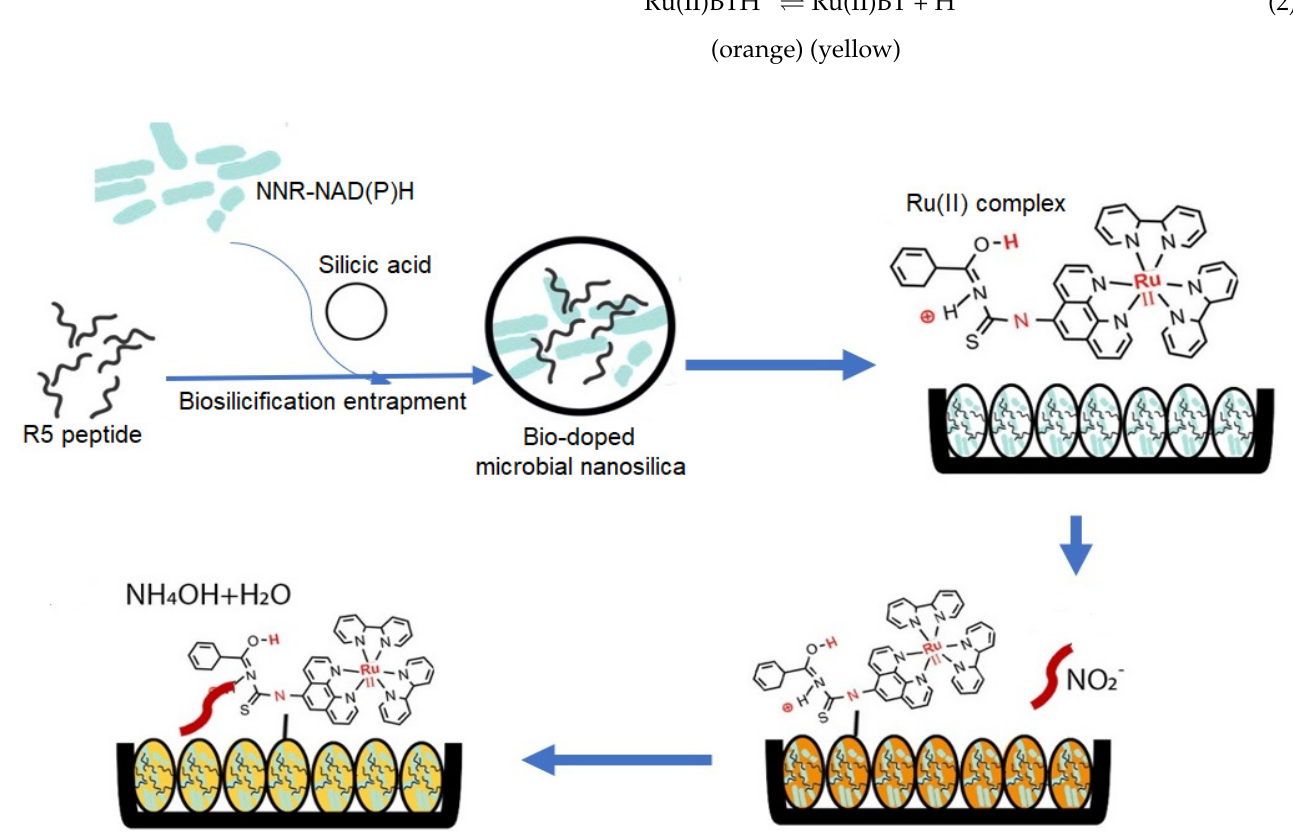
Figure 3. The schematic diagram represents the biomimetic silicification process involving R5 peptide from the silaffin protein of C. fusiformis to initiate the formation of silica nanoparticles with the co-silicification of the microbial intracellular NNR enzyme and cofactor NAD(P)H. Ruthenium complex, the pH optical label, is simply adsorbed to the surface of the R5-fusion nanosilica. The microbial optosensor changes from orange to yellow hue in the presence of nitrite, which can be monitored by the optical reflectometric method.